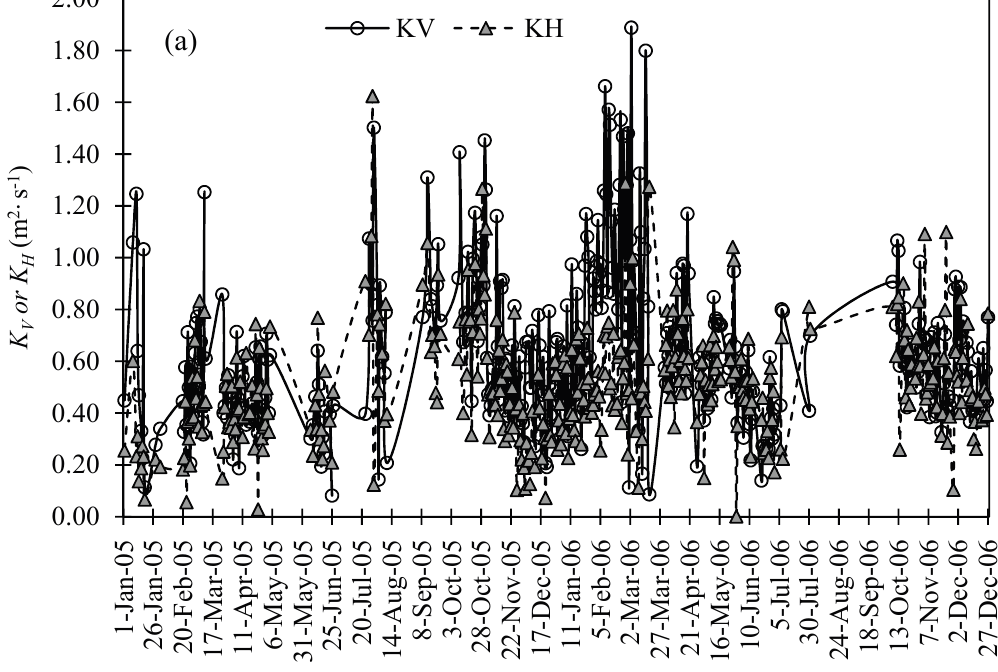
Figure 3. ( a ) Seasonal variations of the daily estimates of K growing and non-growing (dormant) seasons; ( b ) Seasonal variations of the hourly estimates of ; ( c ) Seasonal variations of the hourly estimates of K K V